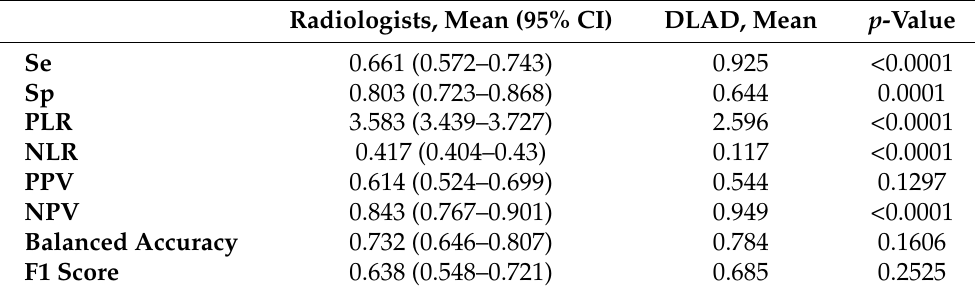
Table 4. Performance of DLAD compared to radiologists’